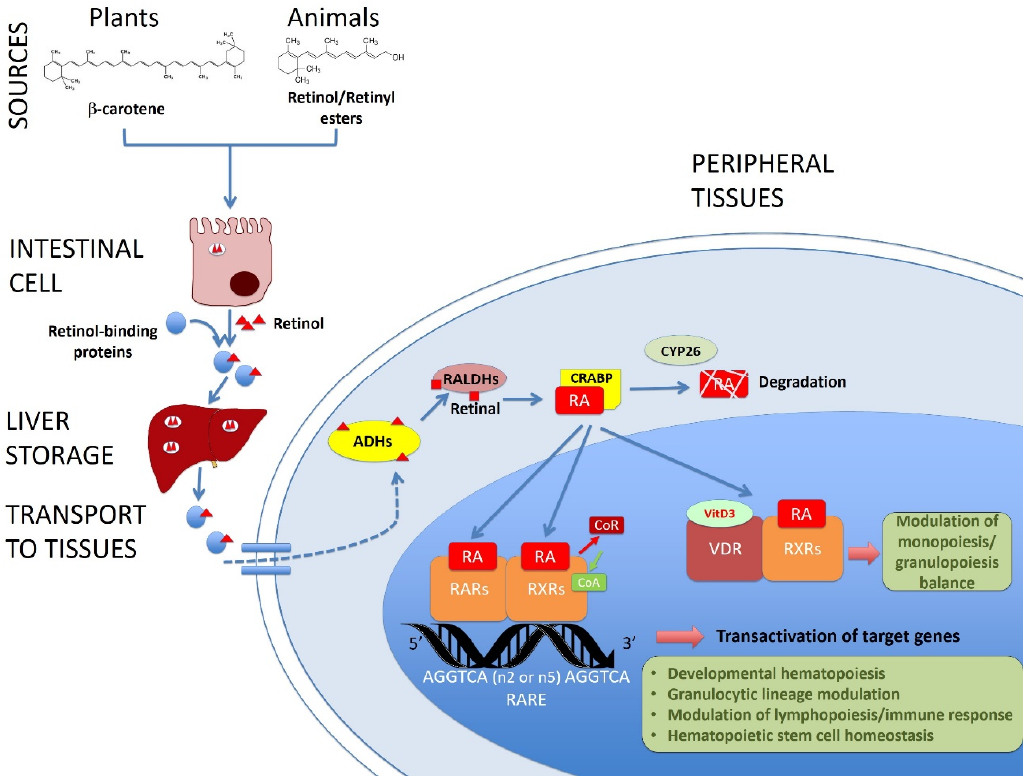
Figure 1. Role of vitamin A/retinol in adult hematopoiesis. This picture shows the main molecular pathways leading from the vitamin A sources to the target genes of the retinoic acid (RA, the active form of vitamin A) related with hematopoiesis in the tissues. Retinol or provitamin A is ingested and absorbed through the intestine, transported by retinol-binding proteins and stored in the liver. Retinol is transformed by the cells into RA by alcohol and aldehyde dehydrogenases (ADHs and RALDHs respectively). RA is transported by cellular retinoic acid binding proteins (CRABP) and it can be degraded by CYP26 or translocated to the nucleus, where it binds and activates nuclear retinoid acid receptors (RARs and RXRs), displacing co-repressors and recruiting coactivators of the transcription of target genes. In this way, RA regulates the developmental hematopoiesis, modulates lympho and granulopoiesis and contributes to the homeostasis of the hematopoietic stem cells. Vitamin D receptor (VDR) can also dimerize with RXRs and modulate the immune response.